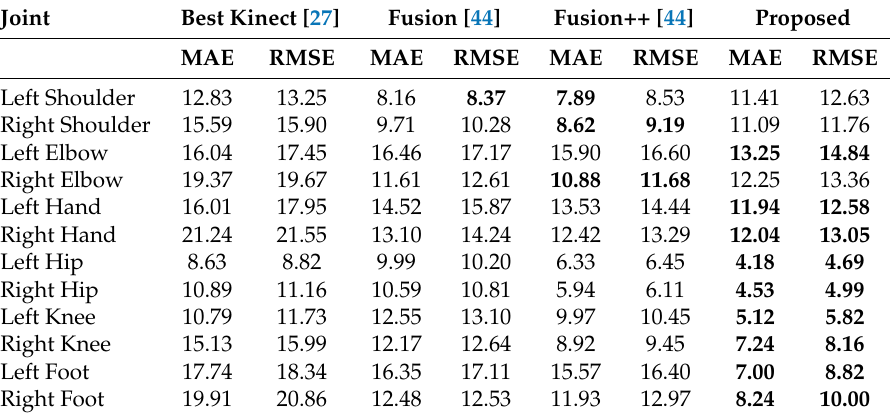
Figure 14. Comparative evaluation of the motion capture methods using total 3D PCK results in different α 3 D threshold values in cm. Table 8. Experimental results of the respective motion capture methods using (MAE) and (RMSE) metrics per joint (in